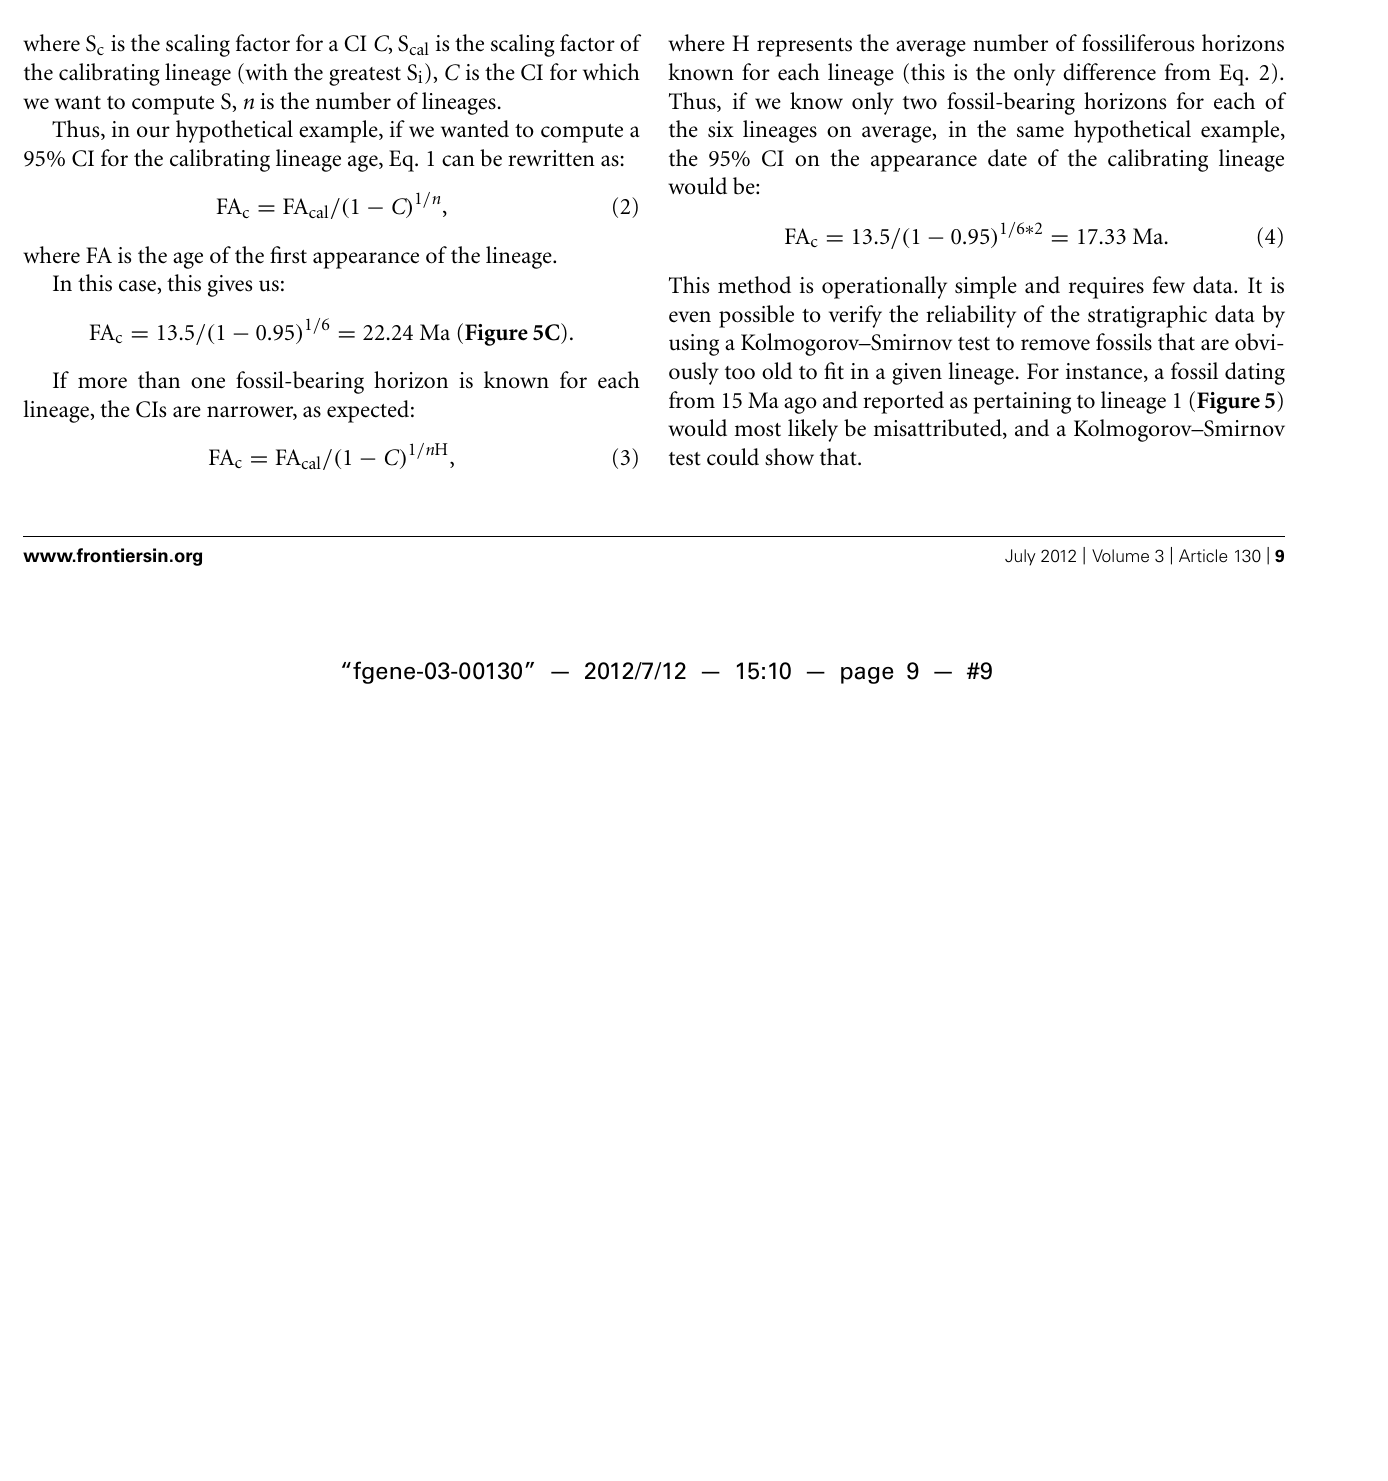
exponential diversification model and various assumed extinction levels of lissamphibians resulting from major biological crises (colored bars 1–4). A model that assumes no impact of major crises on lissamphibians yields a much longer confidence interval (bar 5), whereas one assuming no diversification yields a ridiculously short interval (bar 6). Each bar represents a 75% CI, and the black line in the bar represents the 50% CI.The background tree comes from Marjanovi´c and Laurin (2007) and shows ranges of ages based on different assumptions about minimal branch lengths. Reproduced from Marjanovi´c and Laurin